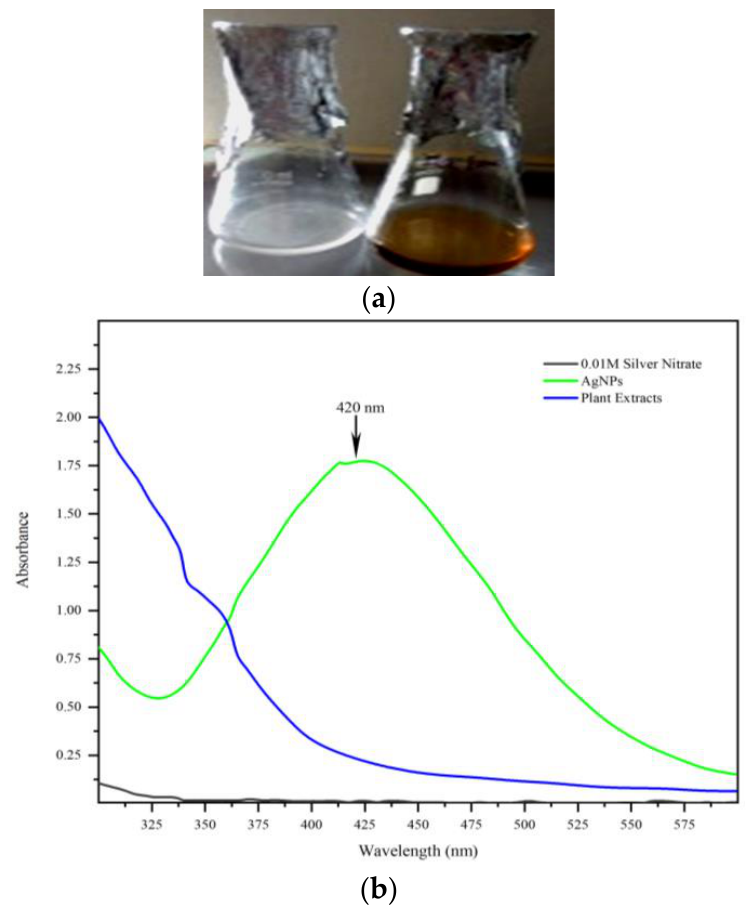
Figure 1. ( a ) Synthesis of MK-AgNPs from mango seed kernel ethanol extract. ( b ) UV–visible spectra of MK-AgNPs.